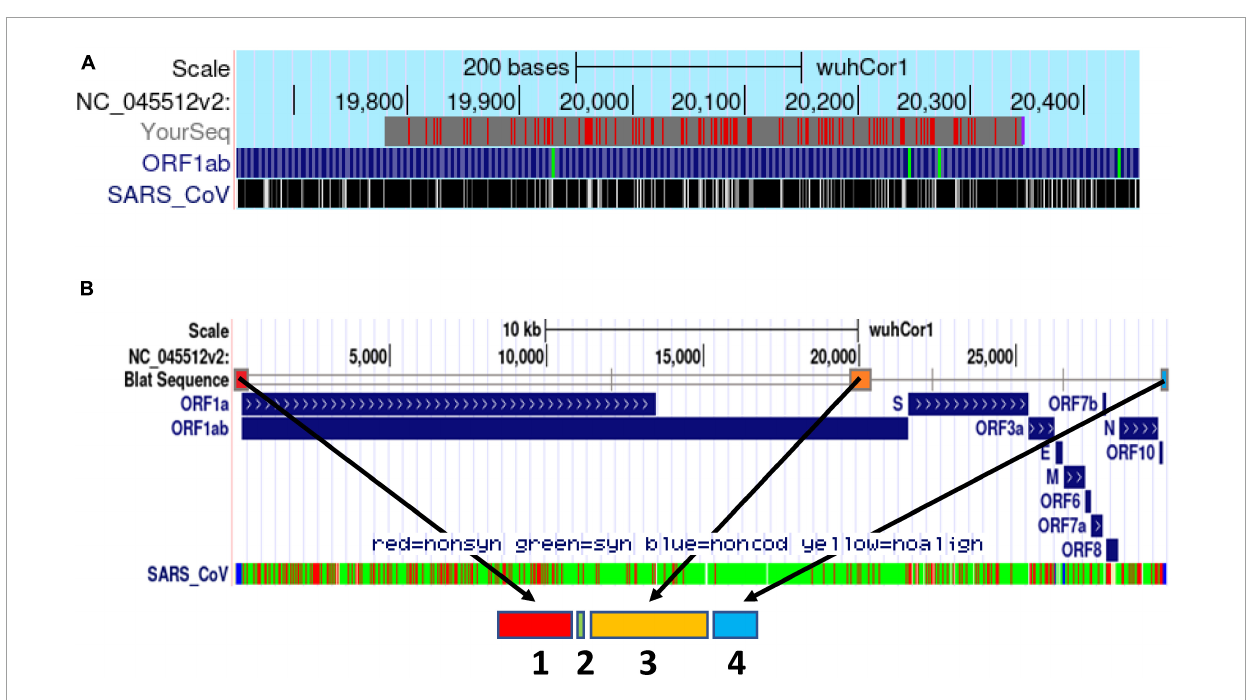
FIGURE1 Schematic delineation of the in silico design of the synthetic PSCT mRNA. (A) Alignment of PS580 sequence of SARS-CoV (position 19715 to 20294) and the SARS-CoV-2 genome (NC_045512.2) using the SARS-CoV-2 BLAT online tool developed by the UCSC Genome Browser Group (red marks: genome and query sequence have different bases at this position). (B) Illustration of the genomic loci of the PSCT mRNA sequence modules within the genome of SARS-CoV-2 using the BLAT search online tool. As indicated by the arrows, the synthetic PSCT was comprised of three relevant conserved CREs (sequence module 1, 3, and 4) and a short artificial sequence of various stop codons (module 2) inserted amidst the first two CRE modules. In addition, as shown in the lowermost portion of panel (B) , we performed in parallel sequence alignment of the PSCT modules and the SARS-CoV isolate TW1 genome (green: synonymous, red: non-synonymous nucleotide substitution, and blue non-coding